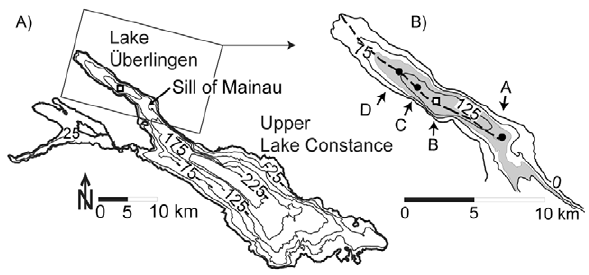
Figure 1. Experimental design. A) Bathymetry of Lake Constance and the location of the main study site (square), B) Zoom into Lake U¨berlingen with deployment stations from October 2010 (A–D), main study site B (square) and thalweg (broken line). The shaded area depicts